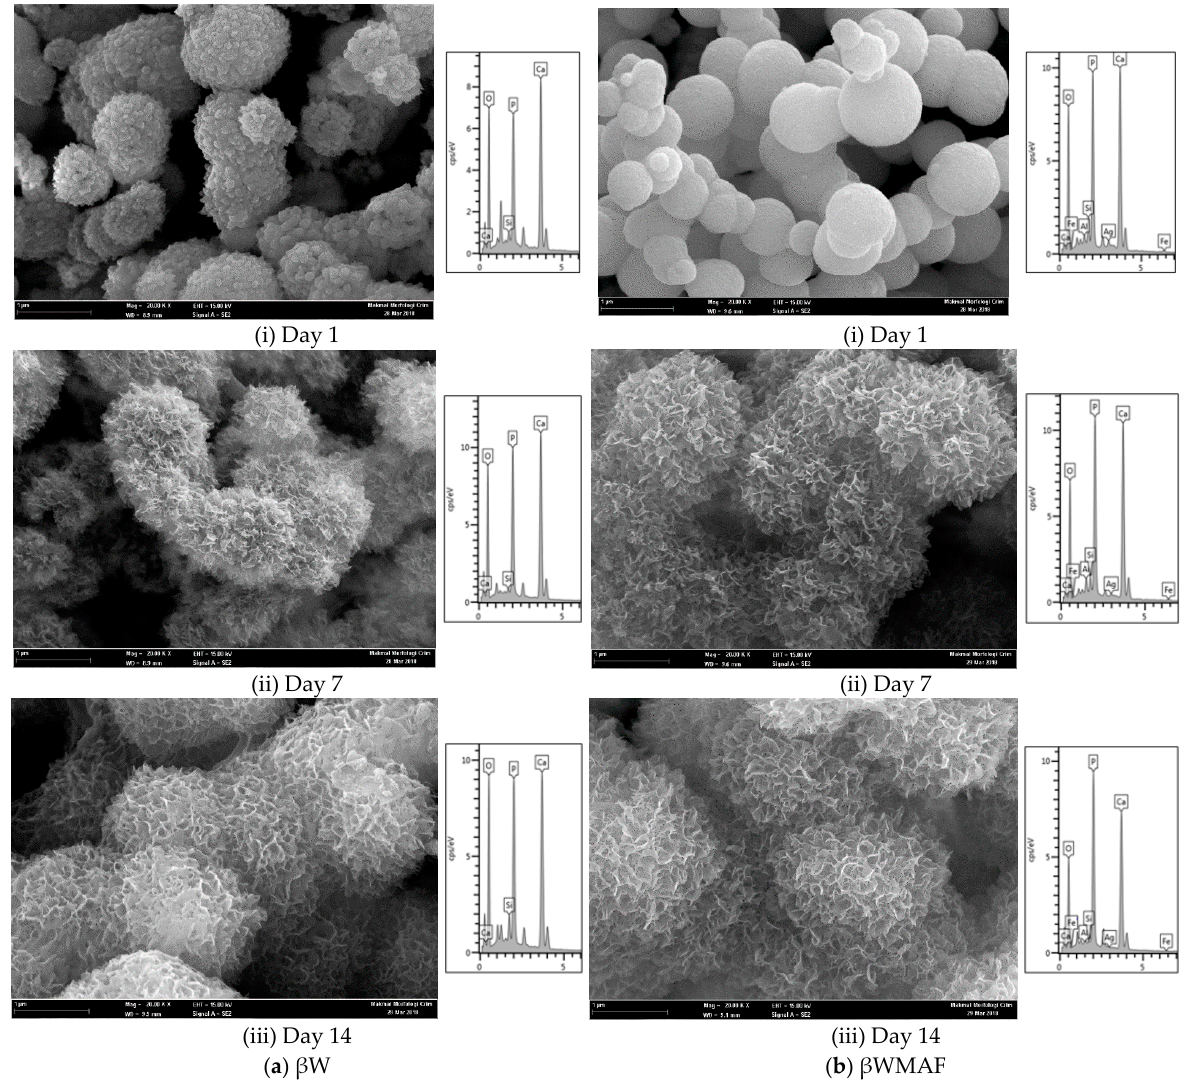
Figure 6. Morphology and elemental analysis of the ( a ) β W and ( b ) β WMAF disc sample after soaking in SBF from day 1 until day 14.